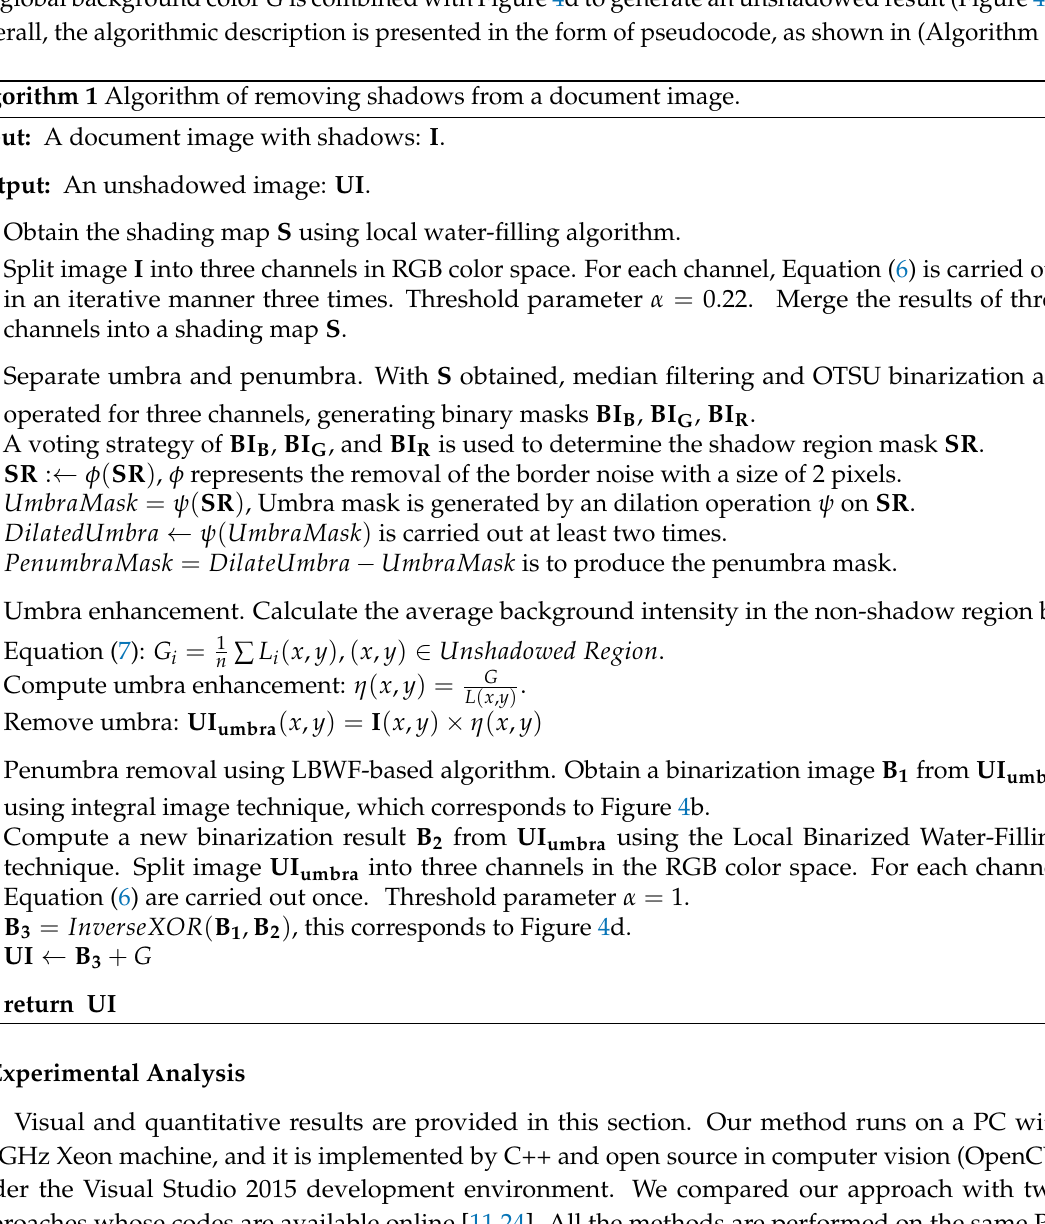
Algorithm 1 Algorithm of removing shadows from a document